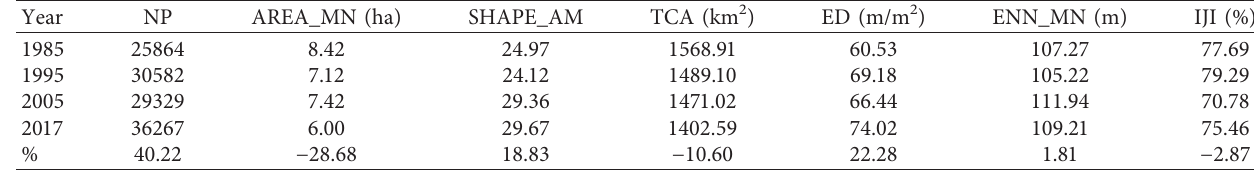
Table 1: Landscape structural characteristic of the BMNP from 1985 to 2017.